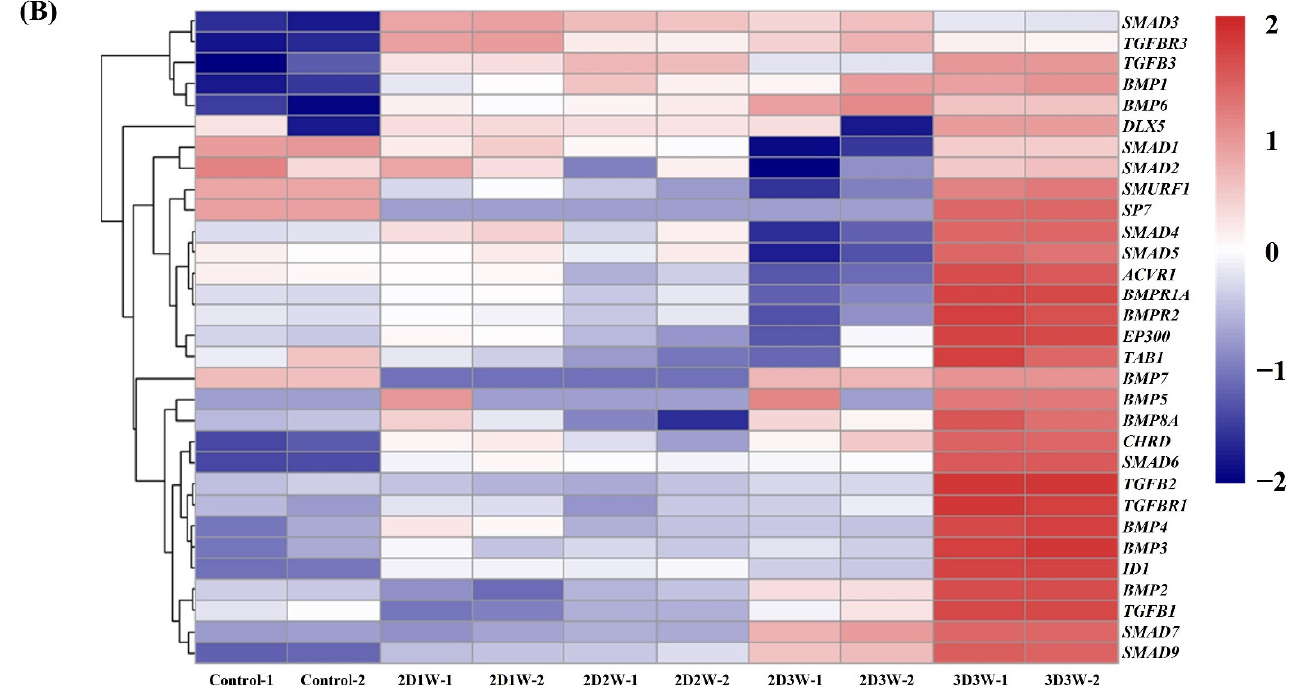
Figure 4. Differentially expressed genes after the differentiation of hADSCs. ( A ) Volcano plots for differential gene expression. Comparison between undifferentiated sample (ADSC) and differentiated sample in 2D and 3D culture conditions. The x and y axes represent the magnitude of fold changes (log2 transformed) and the adjusted p -value ( − log2) by Benjamini-Hochberg correction, respectively. ( B ) A heatmap of the 31 genes associated with the TGF- β signaling pathway. The gene expression of each gene was normalized using TPM and converted into a z-score.